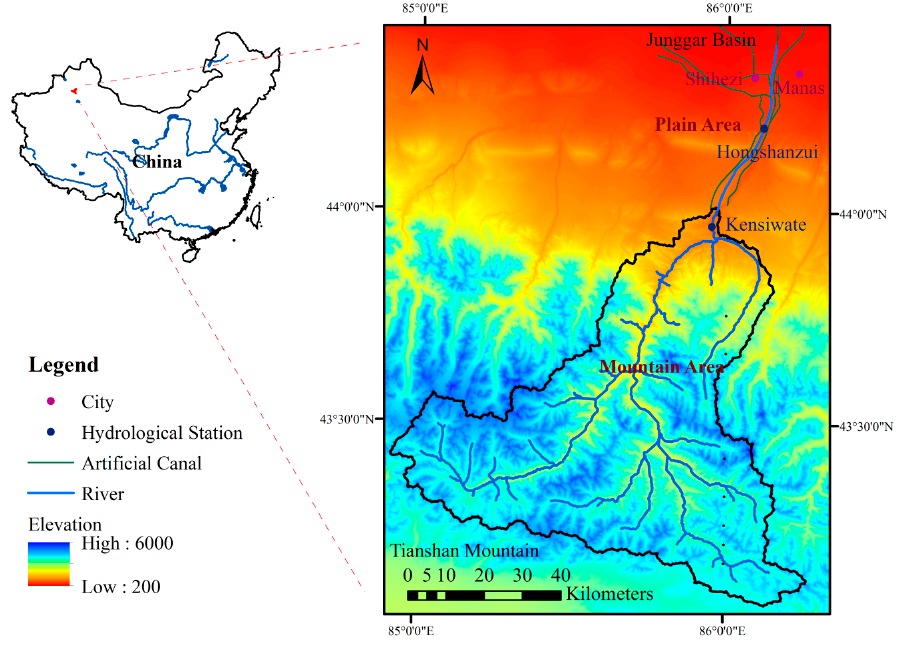
Figure 1. Location of the Manas River basin.